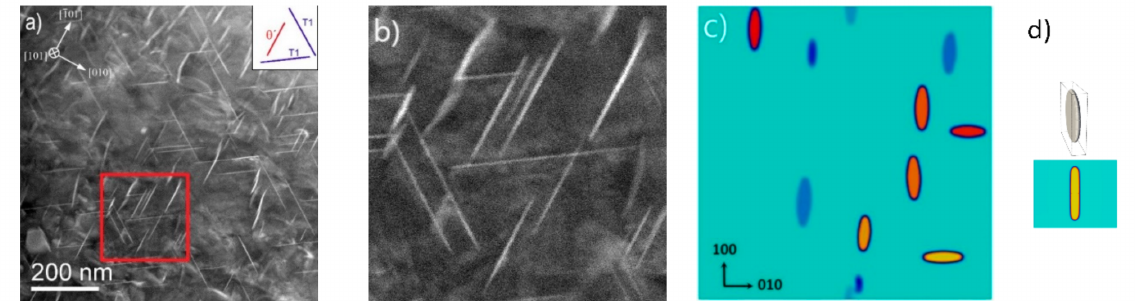
Figure 13. Comparison between the experimental result (Al-4Cu-1Li-0.25Mn alloy, aged 17 h/180 ◦ C; ( a ) overview, ( b ) en- largement, and ( c ) the phase-field simulated morphology of θ (cid:48) precipitates in Al-1.69 at.% Cu alloy at 473 K ( ∆ x = 1.5 nm) at timestep 90,000 s. Note that only one of the 3 plate shaped precipitate variants represent θ (cid:48) (red line in legend ( a )), while the other two are T 1 . ( d ) The single-precipitate simulation (from Figure 6) with ∆ x = 0.7 nm is shown for comparing the effect of grid spacing on the precipitate’s aspect